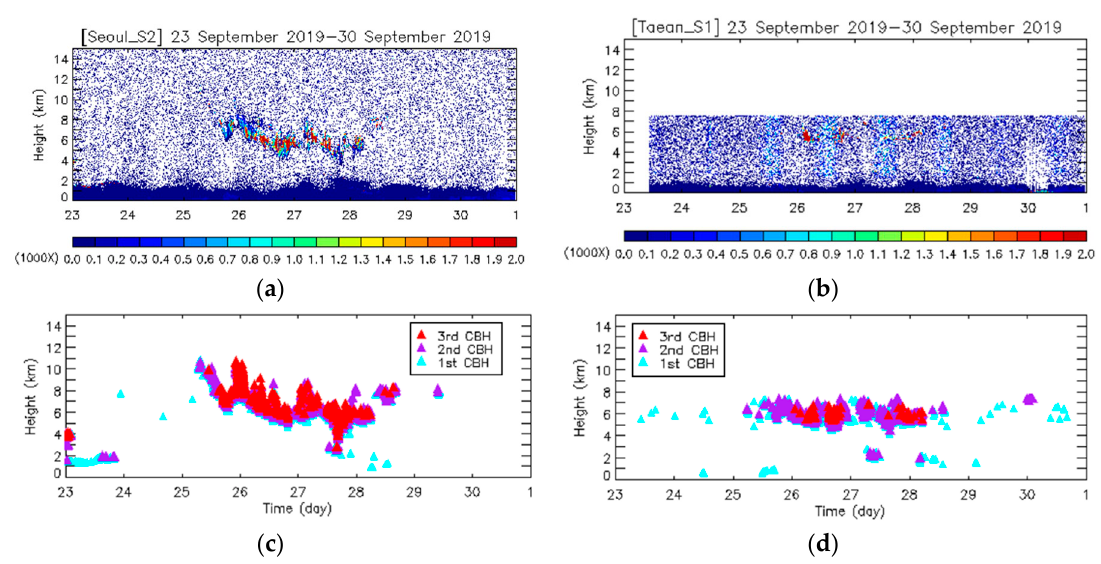
Figure 9. Examples of an autumn case on 23–30 September 2017 at ( a , c ) Seoul (Seoul_S2 station), ( b , d ) Taean (Taean_S1 station); ( a , b ) backscatter profiles and ( c , d ) CBHs detected by ceilometer over Seoul. The color bar represents the intensity of backscatter signals. The cyan, purple, and red triangles represent the 1st, 2nd, and 3rd CBHs, respectively.